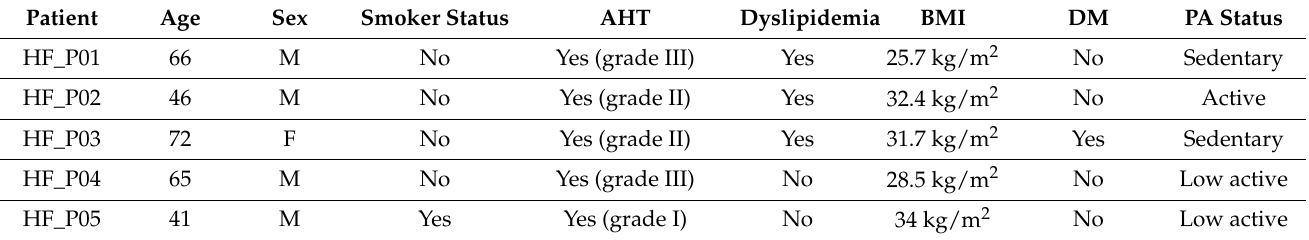
Table 1. Demographic characteristics and cardiovascular risk factors for HF